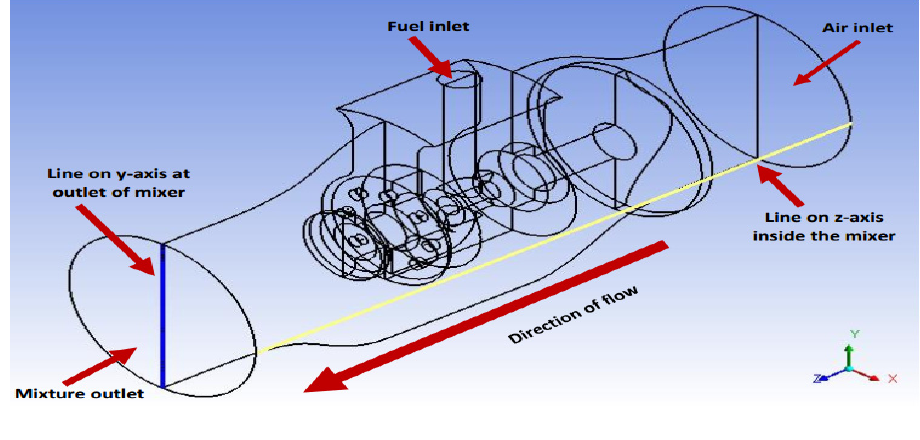
Figure 6. A line in Z -axis direction inside the model 1 which will applied on the four case of meshing.